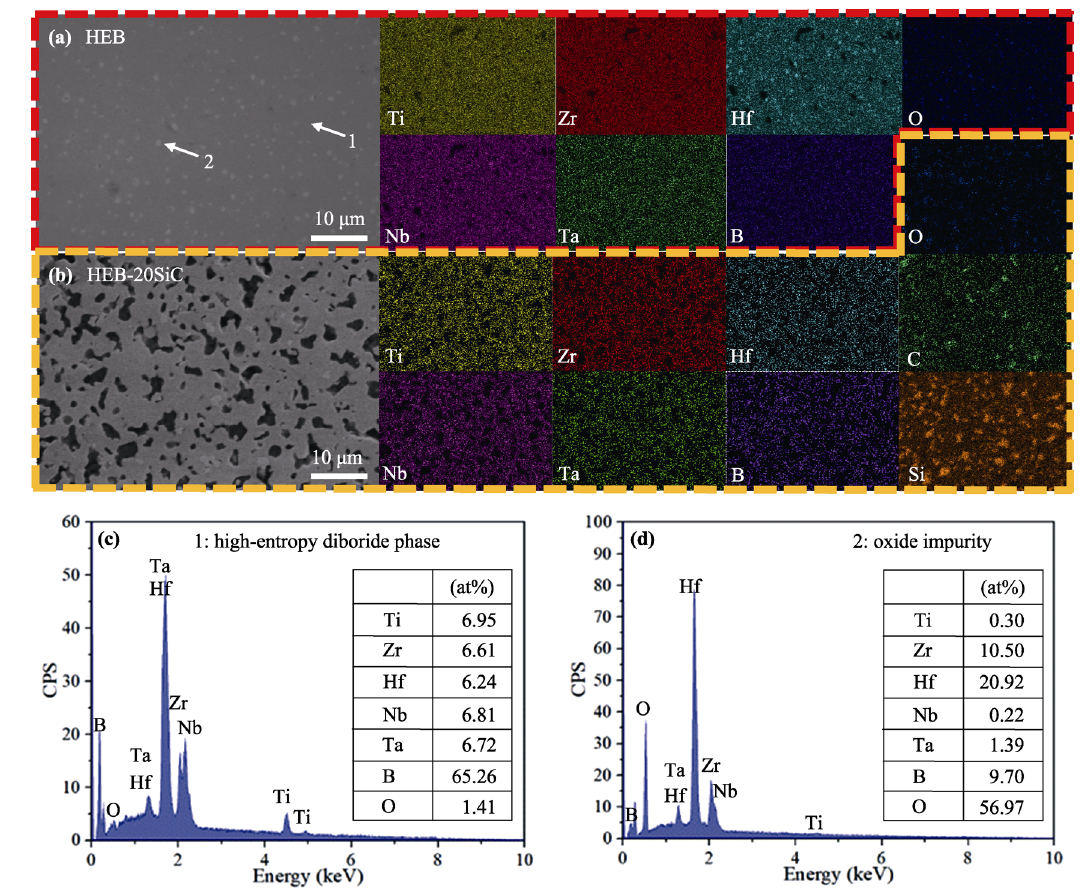
Fig. 2 EDS analysis of the hot-pressed samples. Element mapping of HEB ceramics (a) and HEB–20SiC ceramics (b); the quantitative results of EDS analysis of the high-entropy diboride phase (c) and impurity oxide